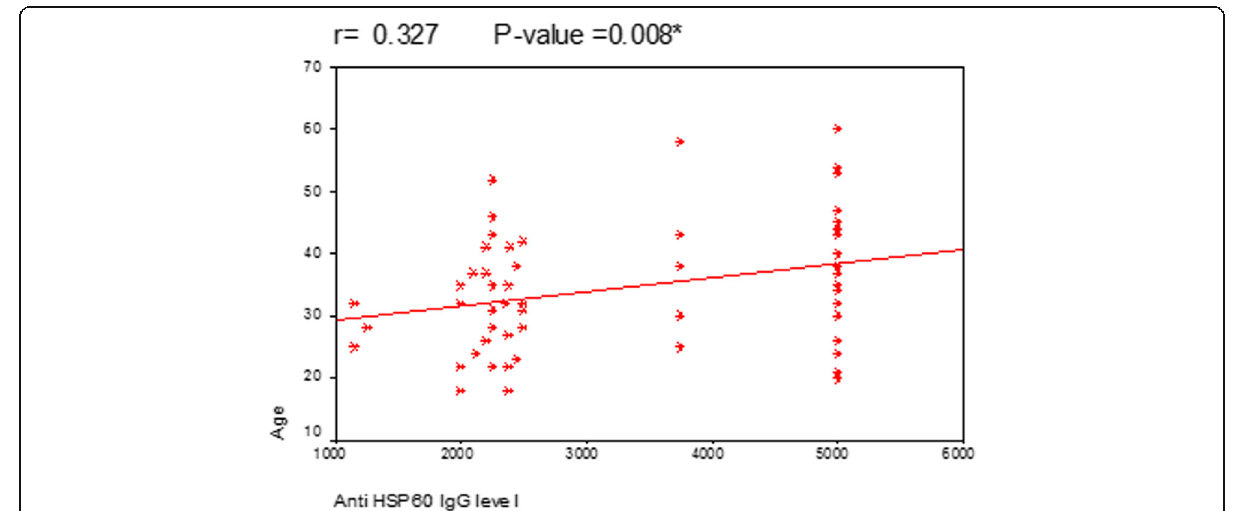
Fig. 1 Correlation between anti Hp hsp60 IgG level and age of the MS patients